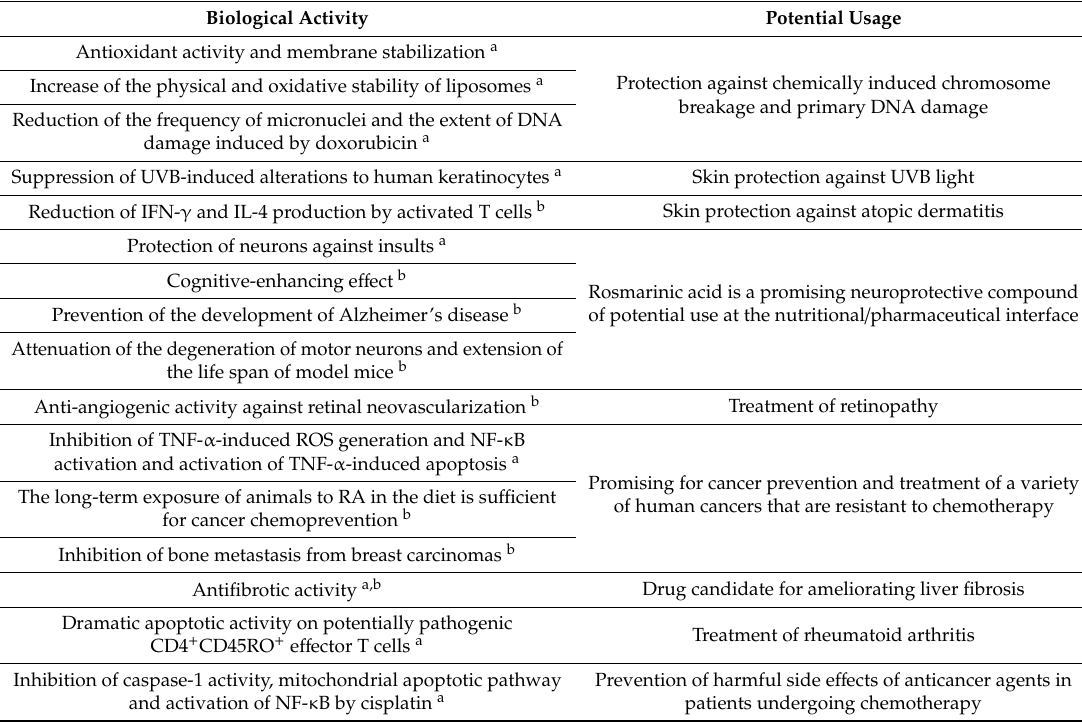
Table 2. Biological activities of rosmarinic acid (RA) (modified from Bulgakov et al.